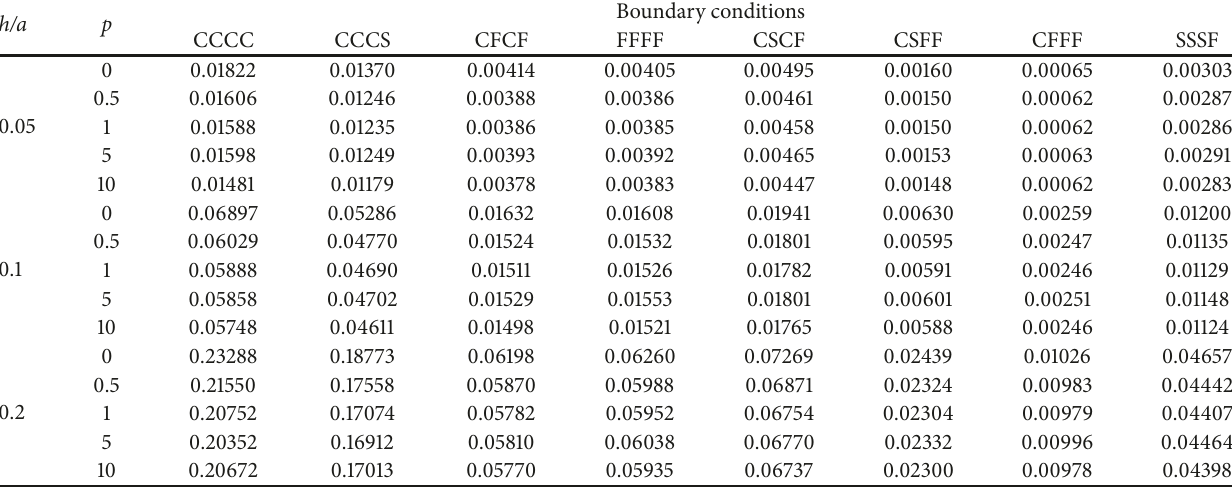
Table 12: Fundamental frequency parameter Ω = 𝜔ℎ(𝜌 𝑐 /𝐸 𝑐 ) 1/2 for Al/ZrO 2 plates with different boundary